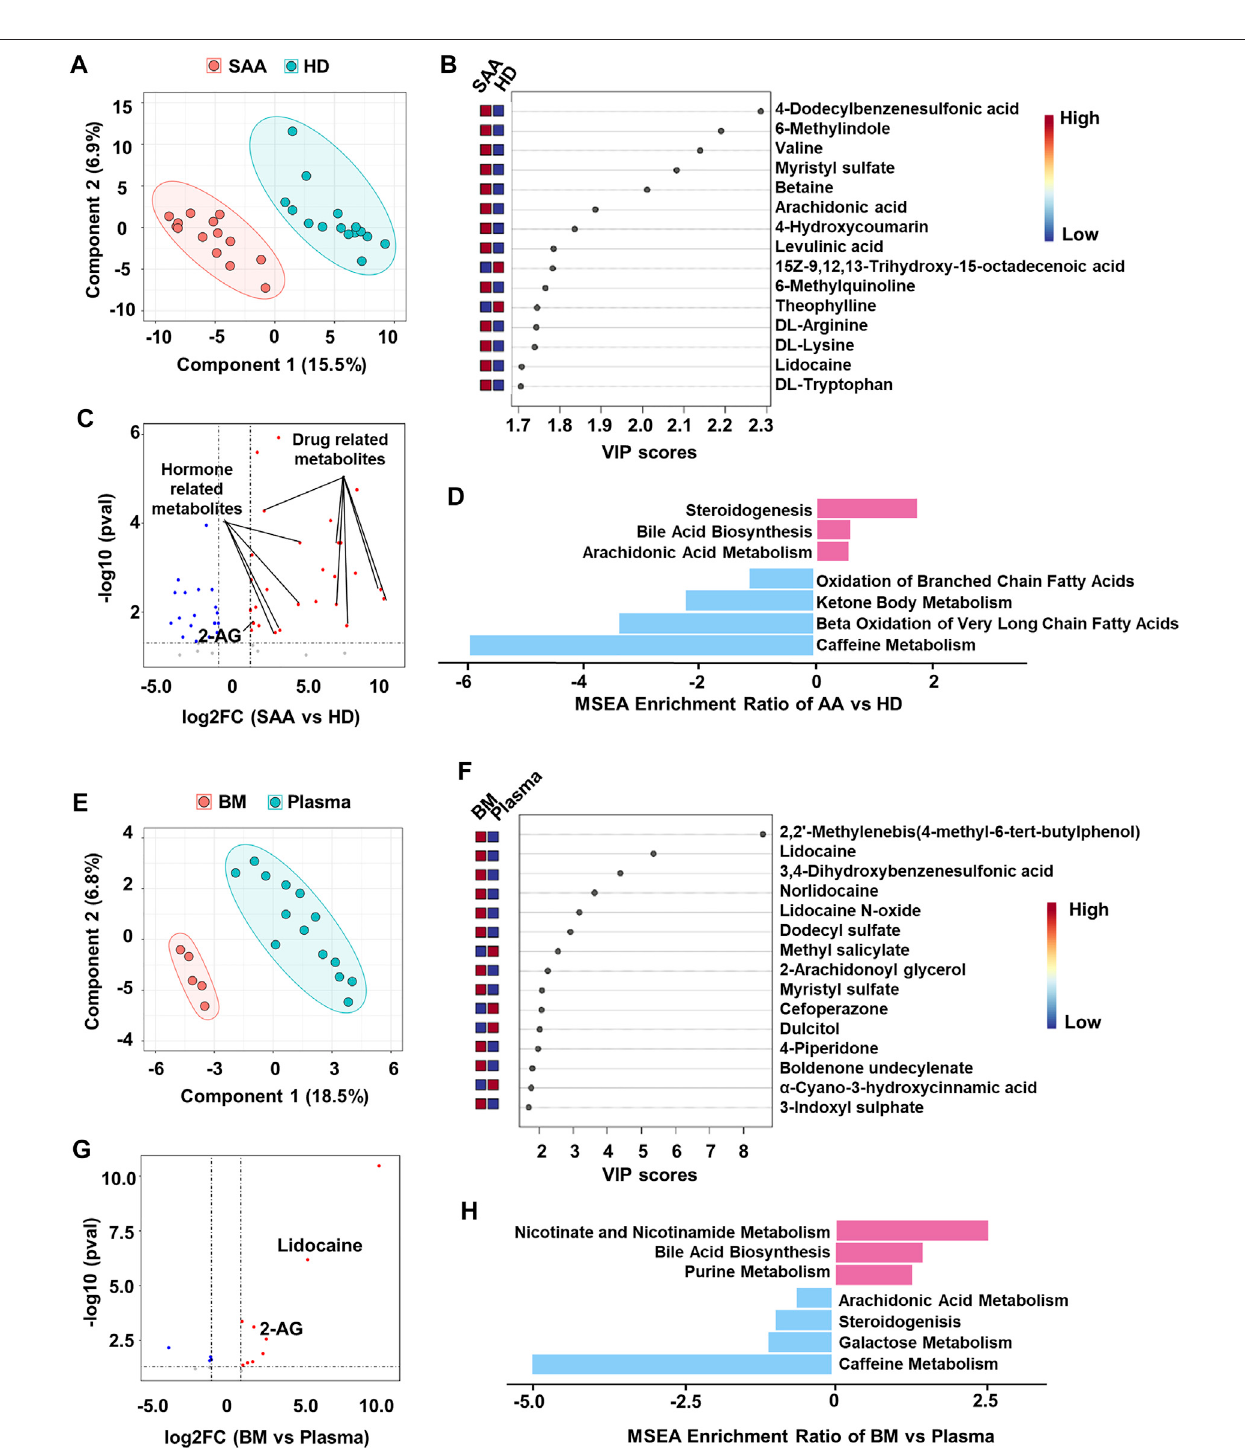
FIGURE2| Metabolomicspro fi lingofplasmafromSAApatients and healthydonors. (A) PLS-DAplotshowingthemetabolic pro fi lesoftheSAA(pinkdots, n (cid:1) 14) and HD (green dots, n (cid:1) 15) groups. (B) The variable importance in projection (VIP) score plot showing the top 15 PLS-DA metabolites that are different between SAA patients and HD. (C) Volcano plot showing differential metabolites (fold change > 2, p < 0.05) between SAA patients and HD analyzed by MetaboAnalyst website. The upregulatedmetabolitesareenriched withdrugand hormone-related metabolites. (D) MSEAplotshowingenriched pathwaysofupregulated(foldchange > 2)and downregulated (fold change < 2) metabolites in the SAA group. (E) PLS-DA plot showing metabolic pro fi les of the BM supernatant (pink dots, n (cid:1) 5) and plasma (green dots, n (cid:1) 14) in SAA patients. (F) VIP score plot showing the top 15 PLS-DA metabolites that are different between BM supernatant and plasma. (G) Volcano plot showing differential metabolites (fold change > 2, p < 0.05) between BM supernatant and plasma analyzed by MetaboAnalyst website. (H) MSEA plot showing enriched pathways of upregulated (fold change > 2) and downregulated (fold change < 2) metabolites in BM supernatant of SAA patients. SAA, severe aplastic anemia; PLS-DA, partial least squares discriminant analysis; HD, healthy donors; MSEA, metabolite set enrichment analysis; BM, bone marrow.